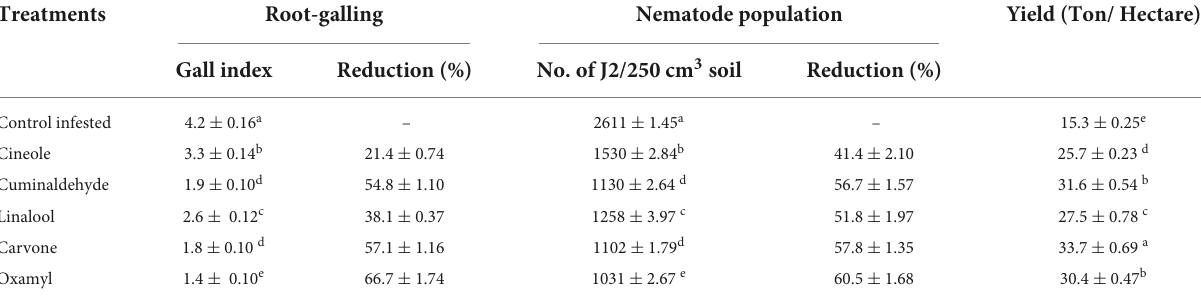
TABLE 6 Effect of treatments on root galling, nematode population and yield in tomato plants grown in soil infested with M. incognita under field conditions. Treatments Root-galling Nematode population